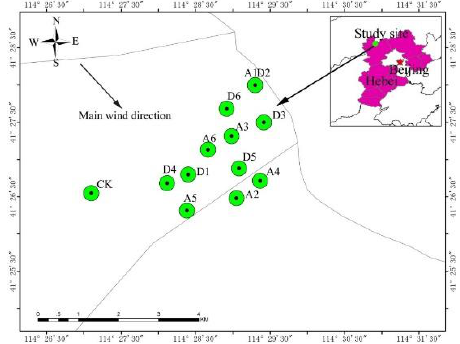
Figure 1. Location of the study area in Zhangbei County, Hebei Province, China. The green circle with black dots represents the location of the field site. CK, the control site; D1, site with a forest density of 500 trees · hm − 2 ; D2, site with a forest density of 750 trees · hm − 2 ; D3, site with a forest density of 1025 trees · hm − 2 ; D4 site with a forest density of 1200 trees · hm − 2 ; D5, site with a forest density of 1425 trees · hm − 2 ; D6, site with a forest density of 1700 trees · hm − 2 . A1, site with a forest age of 15 years (A1 and D2 are the same parcel); A2, site with a forest age of 21 years; A3, site with a forest age of